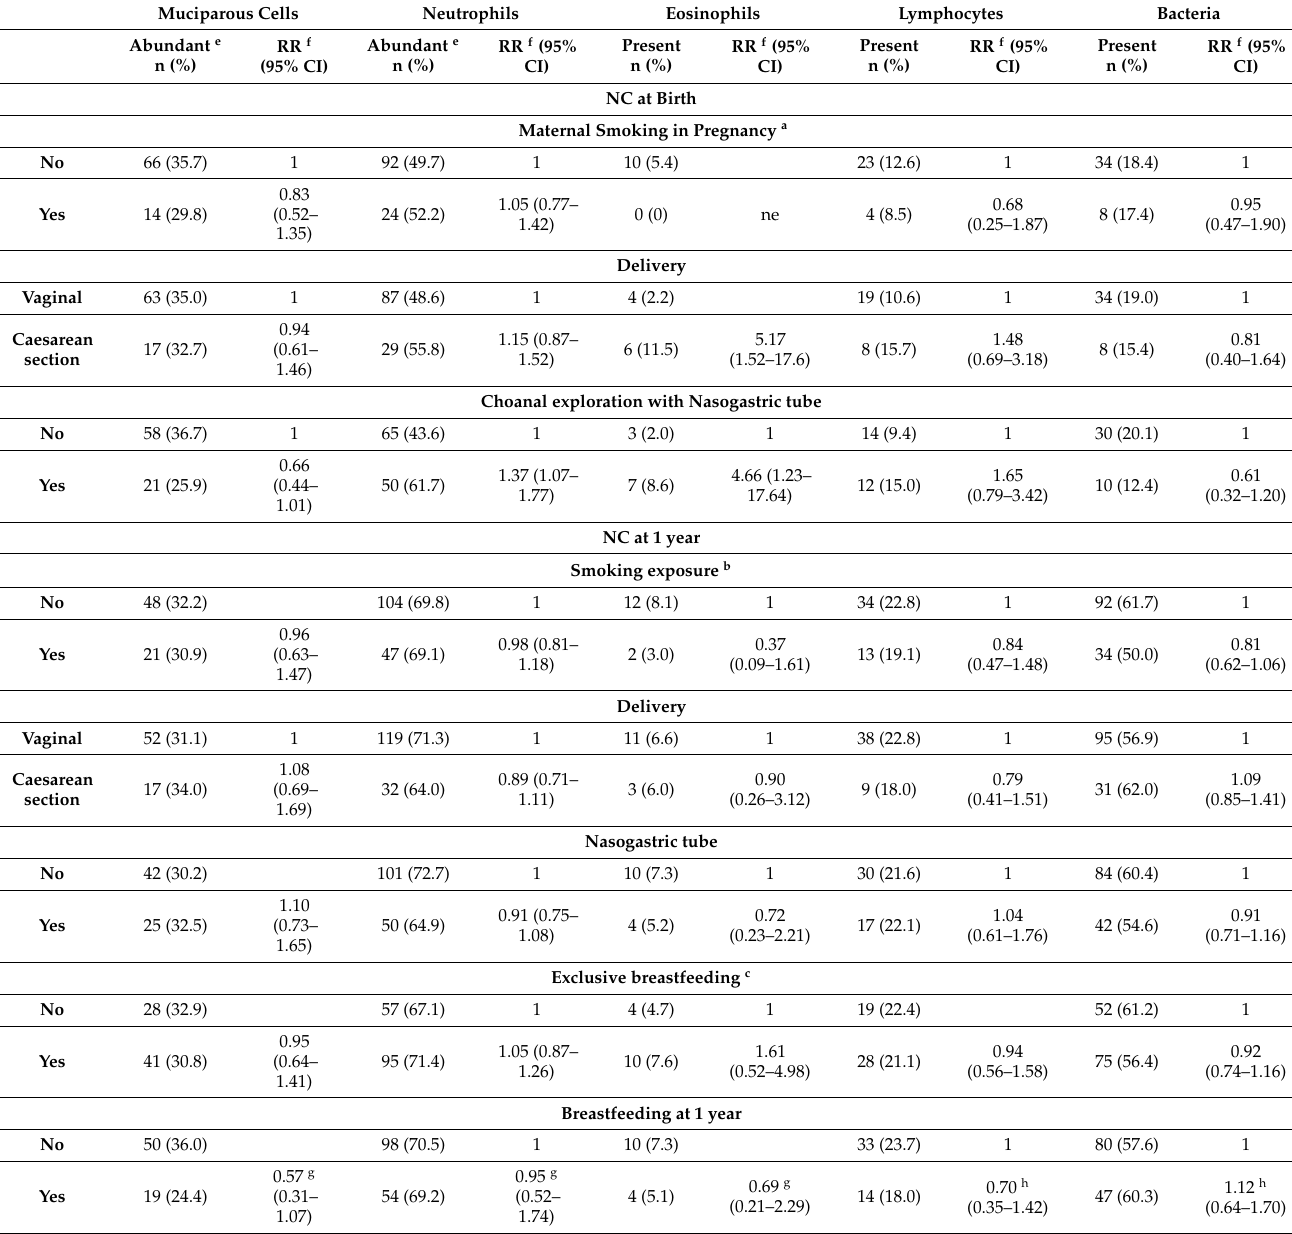
Table 3. Association of type of delivery, nasogastric tube, exposure to smoking, and breastfeeding with nasal mucosa cytological composition at birth, 1, and 3 years of